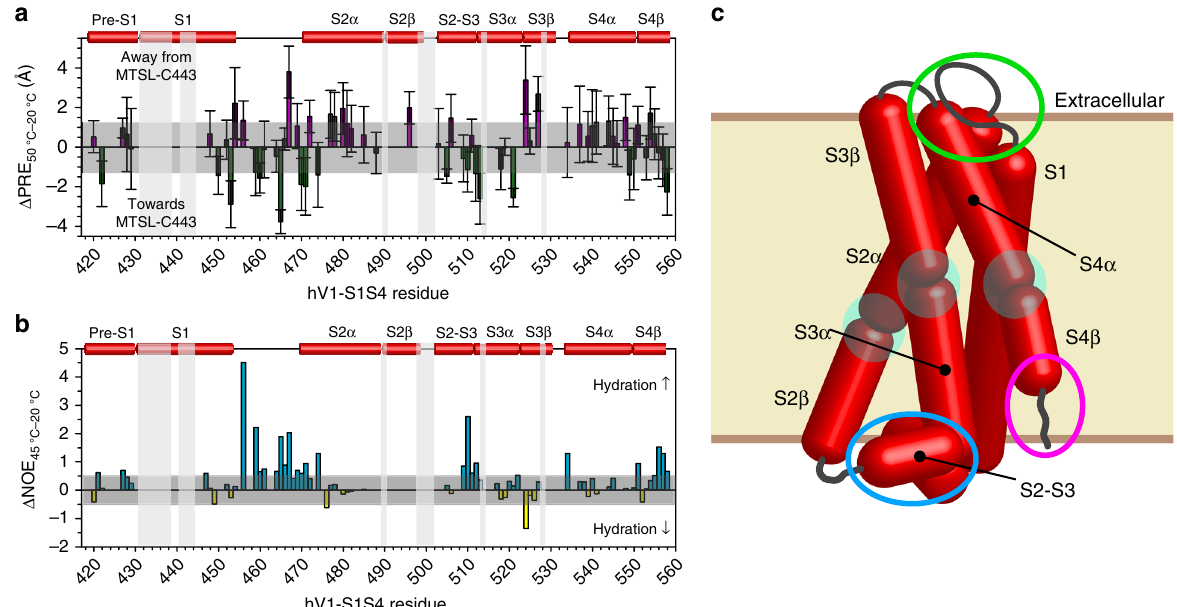
Fig. 4 hV1-S1S4 undergoes discrete temperature-induced changes in distances, and solvent accessibility. a Temperature-dependent differences in distances measured using paramagnetic relaxation enhancement ( Δ PRE) of the hV1-S1S4 at 20 and 50 °C. The average of the s.e.m, 1.2 Å, was used as a threshold value and shown in gray. Errors are propagated s.e.m. b Changes in hydration as a function of temperature were measured from normalized H N – water resonance intensities from 15 N-NOESY-TROSY data at 20 and 45 °C. The Δ NOE 45°C − 20°C is re fl ective of changes in hydration where loops and the bottom of S4 helix exhibit increased hydration at elevated temperatures. c A cartoon of hV1-S1S4 identifying regions that change as a function of temperature. Blue and magenta circles indicate increased and decreased helicity, respectively. The green circle highlights differences in the S1 – S2 loop solvent accessibility. Transmembrane helix distortions are highlighted as transparent cyan circles. The blue highlighted region shows helical differences in the vanilloid binding site and the magenta identi fi es the C-terminus of the S4 helix which becomes more solvent exposed and less helical at elevated temperatures. Source data are provided as a Source Data fi